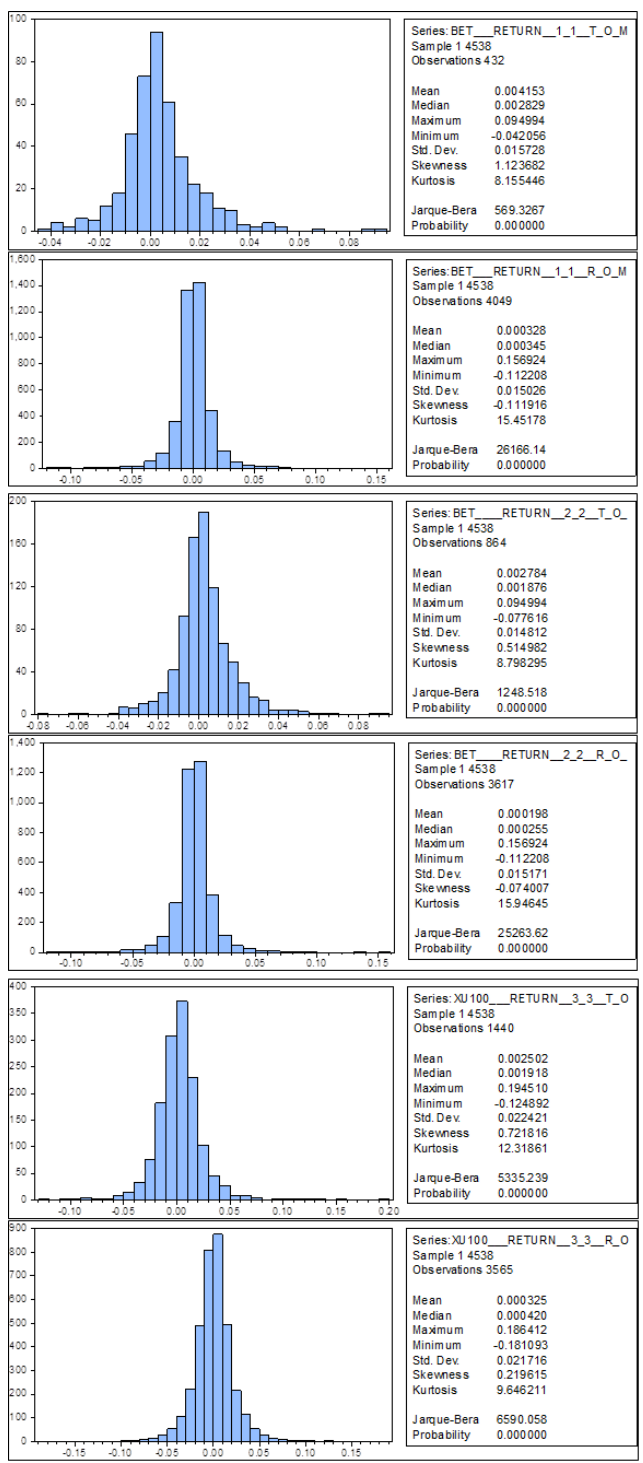
Figure A1. Histograms and descriptive statistics for data samples with highest difference between average T-o-M and R-o-M returns.